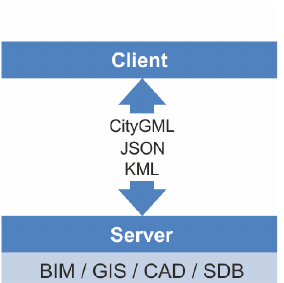
Figure 7. Client/Server architecture for 3D information interchange.